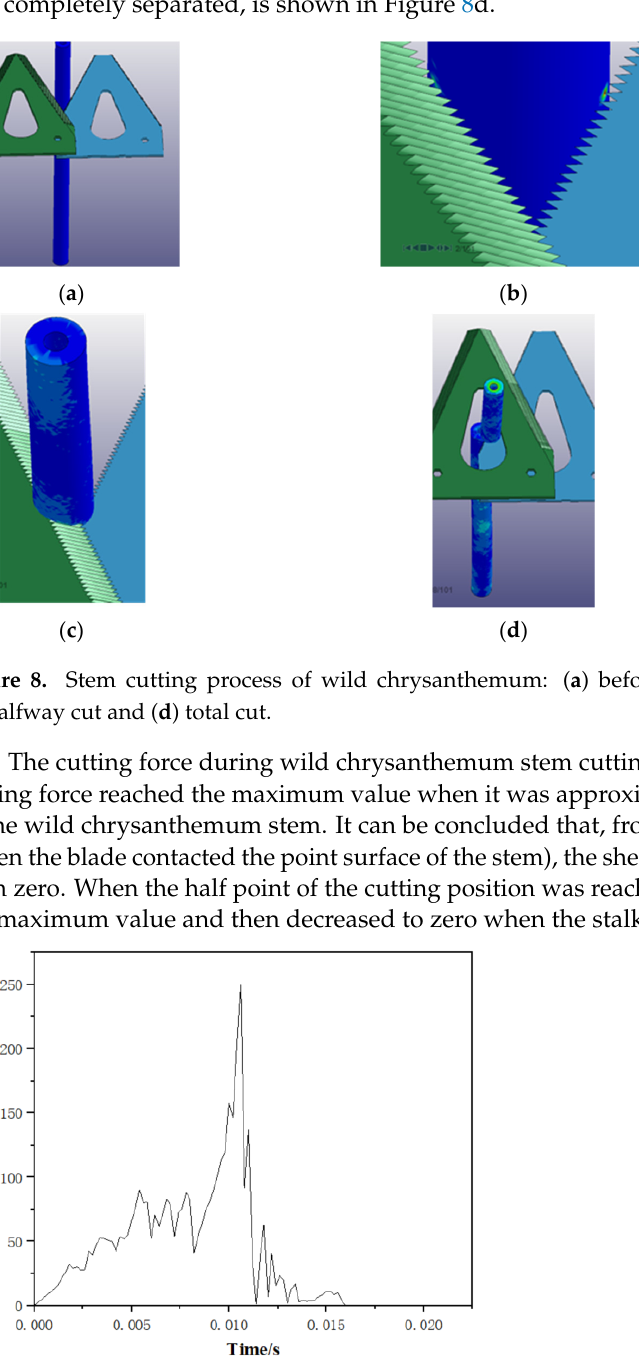
Figure 10. Energy change curve. 3.2. Central Composite Design Experiment The experimental design scheme and results are shown in Table 5. Multiple regres- sion fittings were conducted on the data provided in Table 5. Thus, the regression equa- tion of maximum shear force and power consumption of wild chrysanthemum stem could be obtained: Y 1 = 201.34 + 14.36 X 1 + 2.19 X 2 + 2.36 X 3 + 10.94 X 1 X 2 + 17.49 X 1 X 3 + 11.49 X 2 X 3 − 8.89 X 12 − 1.48 X 22 + 0.1954 X 32